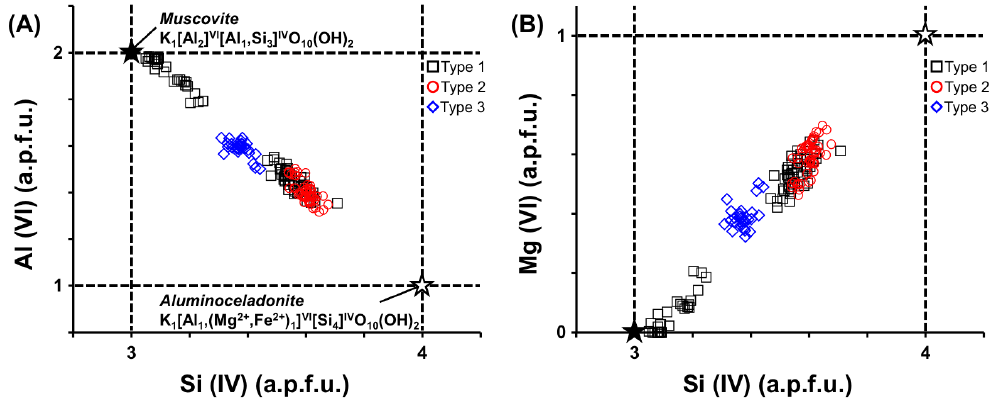
Figure 8. Plots on the diagram of Al(VI) versus Si(IV) ( A ) and Mg(VI) versus Si(IV) ( B ) for the Type 1, 2 and 3 phengites from the Haengmae Formation. The trends show the theoretical hetero-valence substitution of Al VI Al IV ↔ (Mg,Fe) VI Si IV for charge-balancing in the phengite-series solid